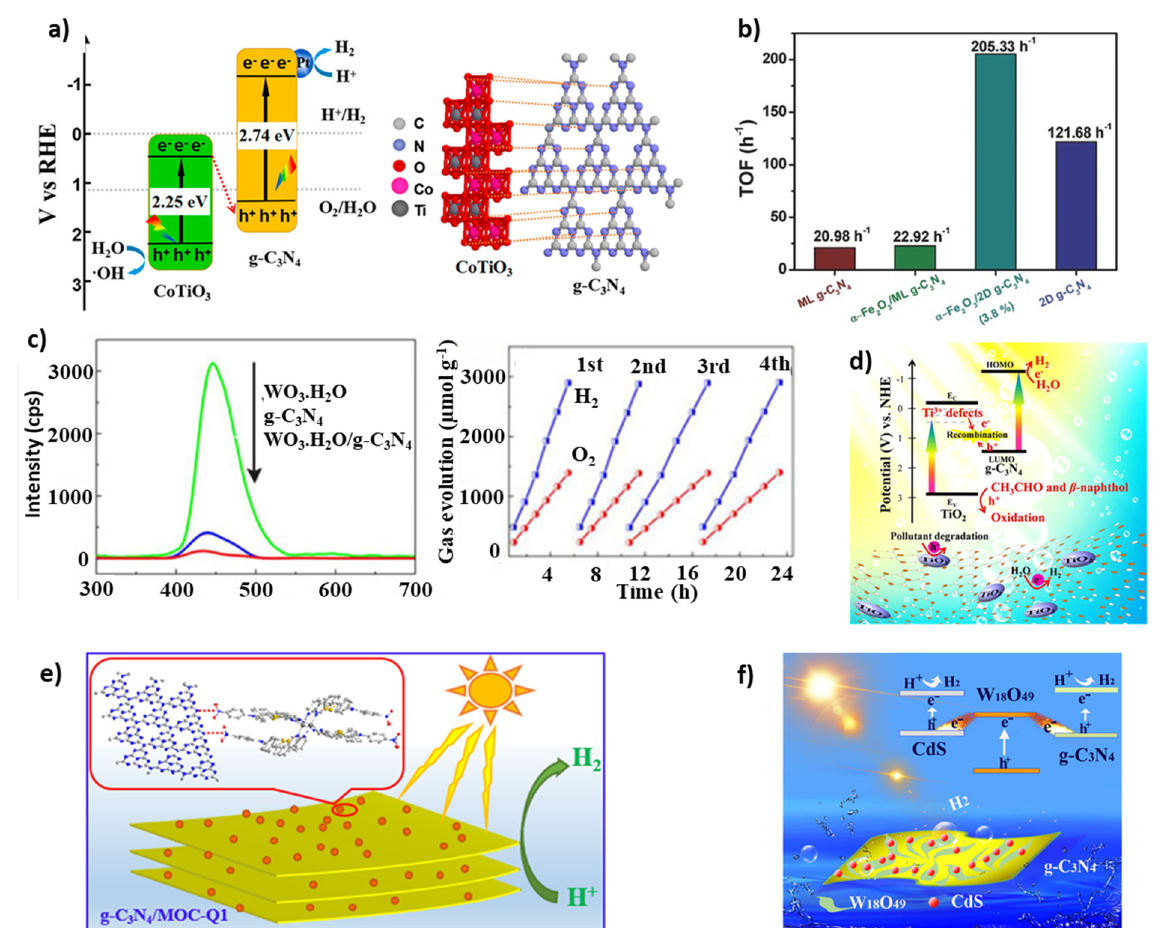
Figure 10. ( a ) Schematic illustration of the mechanisms for charge carrier separation of CoTiO 3 / g - C 3 N 4 direct Z-schemes and the molecular interaction between CoTiO 3 and g -C 3 N 4 through the formation of chemical bonds. Reproduced from [151]. Copyright 2016, ACS Publications. ( b )